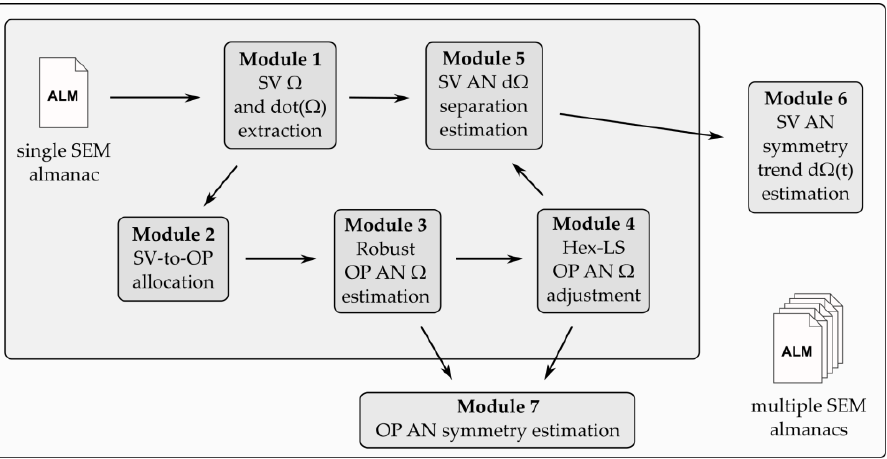
Figure 1. The workflow of the research algorithm.